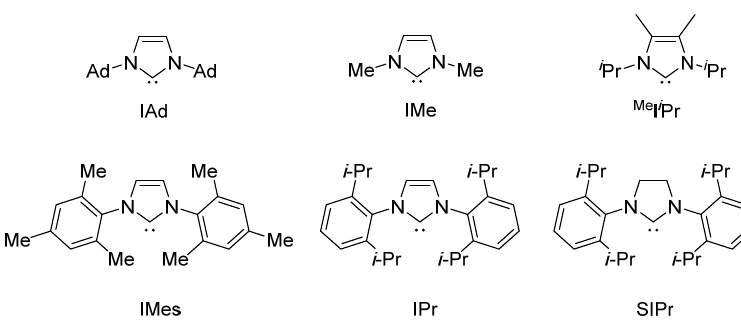
Figure 1. Frequently utilized N -heterocyclic carbenes and their acronyms. Ad = adamantanyl.